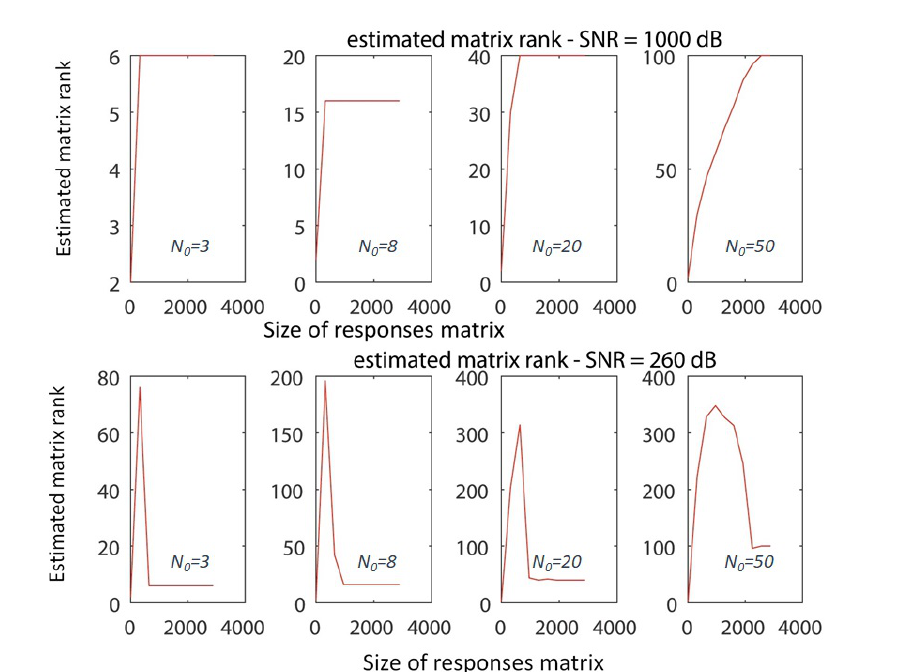
Figure 6. The rank of the responses matrices as a function of the responses matrix dimensions, for the case of Equation 6, where f 0 [ n ] = sin [ n ] and the upper limit of the sum N 0 varies. The values of N 0 are shown within the plots.